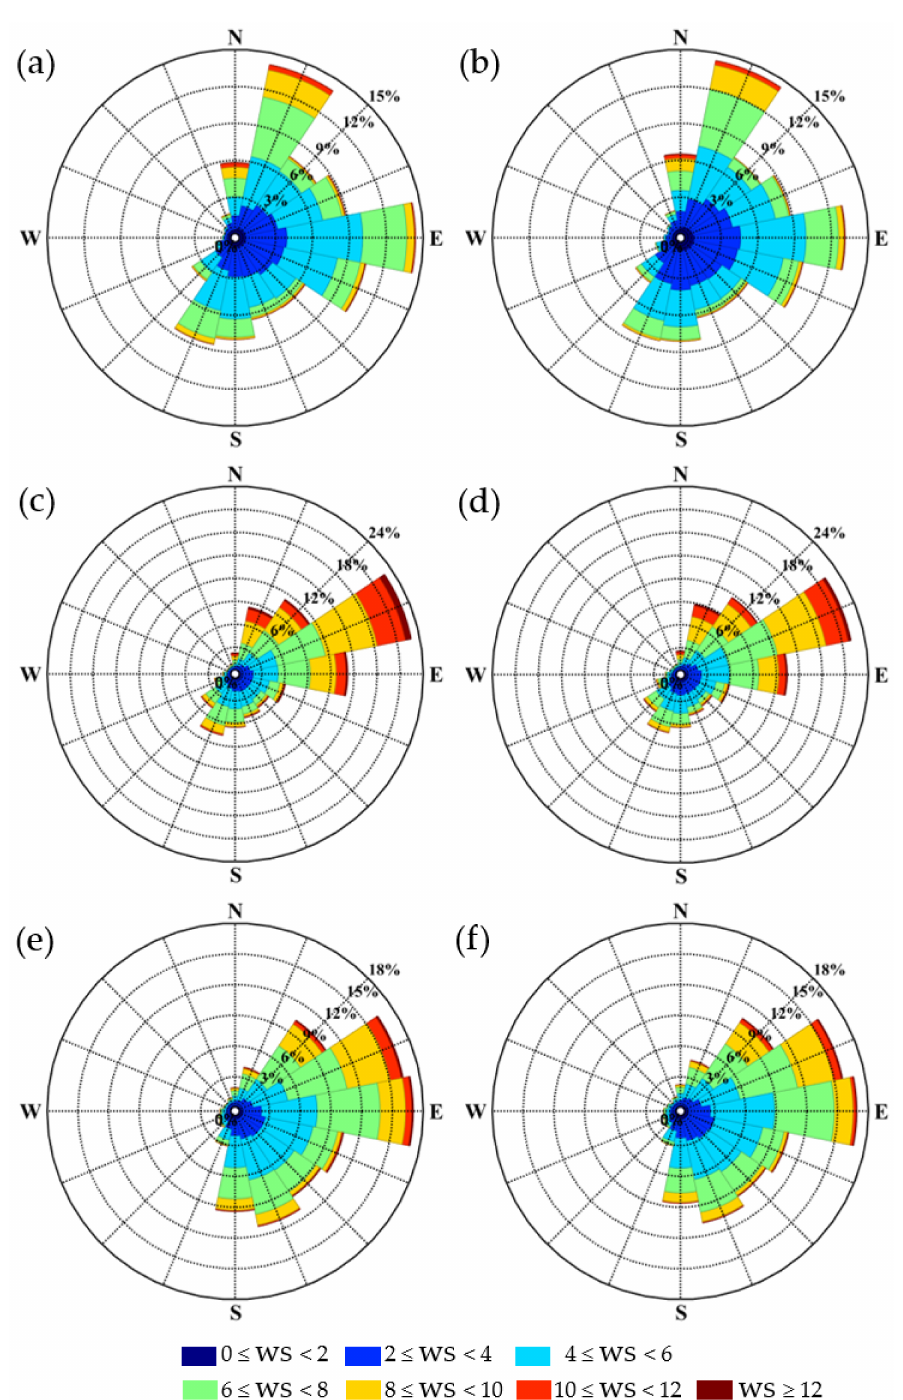
Figure 7. Wind rose before (left column) and after (right column) the change point of wind at station A ( a , b ), station B ( c , d ) and station C ( e , f ). WS represents wind